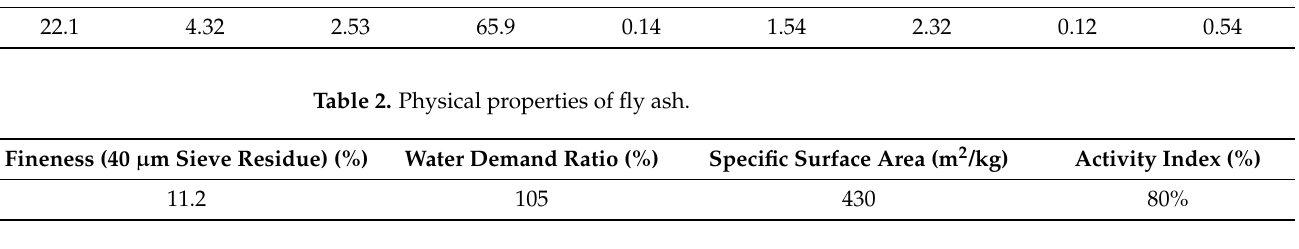
Table 3. Physical properties of coarse